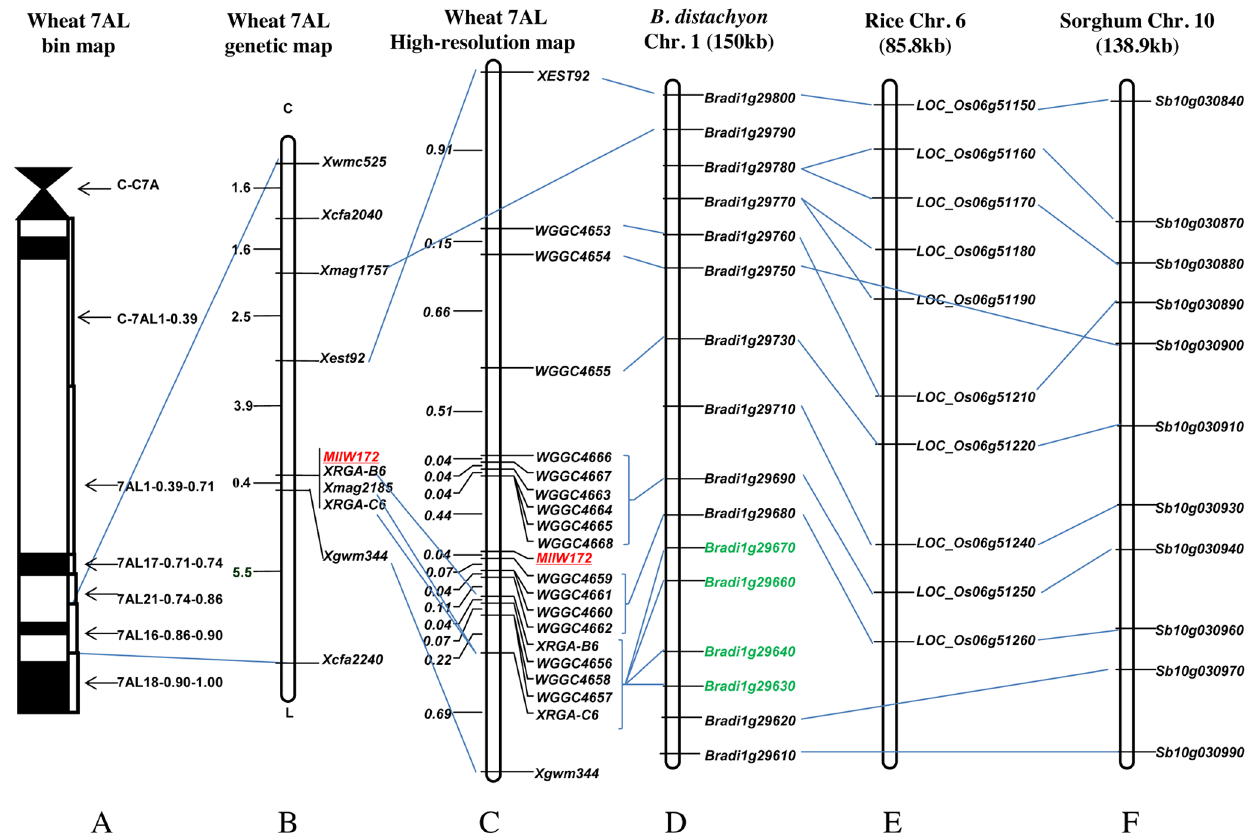
Figure 1. Genetic and comparative genomics linkage map of powdery mildew resistance gene MlIW172 derived from wild emmer. A: MlIW172 physical bin map. MlIW172 was mapped to the distal bin 7AL16-0.86-0.90. B: Preliminary MlIW172 genetic map on wheat chromosome arm 7AL with genetic distances in cM shown on the left, markers shown on the right. C: MlIW172 high-resolution genetic map on wheat 7AL arm with genetic distances in cM shown on the left, EST-STS, EST-SSR and SSR markers shown on the right. Molecular markers that were previously assigned to the 7A wheat deletion bin map ( A ) are connected to the physical map with solid lines. The MlIW172 locus is in red and underlined. The markers which served as anchors, establishing colinearity between the MlIW172 genetic map and the sequences of Brachypodium , rice and sorghum, are connected to the Brachypodium gene with solid lines. D: The MlIW172 orthologous genomic region on Brachypodium chromosome 1 (150kb) with orthologous genes shown on the right. The four genes in green represent the RGA cluster. E: The MlIW172 orthologous genomic region on rice chromosome 6 (85.8kb) with orthologous genes shown on the right. F: The MlIW172 orthologous genomic region on sorghum chromosome 10 (138.9kb) with orthologous genes shown on the